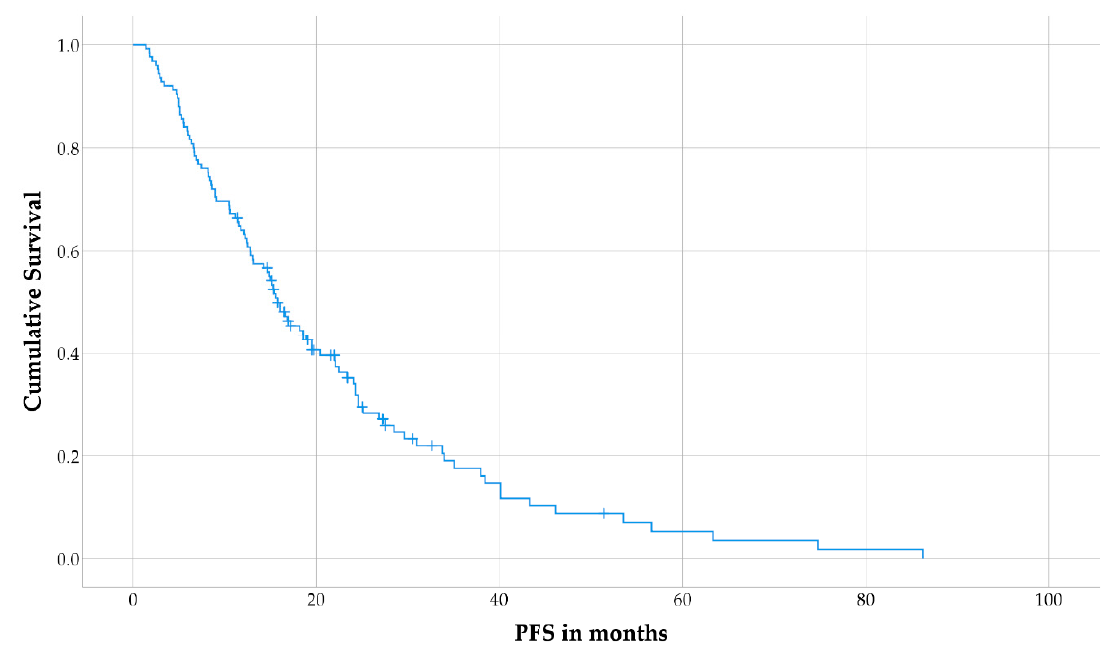
Figure 1. Kaplan–Meier curve for progression-free survival (PFS) in the total cohort. Patients with a high De Ritis ratio (>0.927) had a significantly shorter PFS (median: